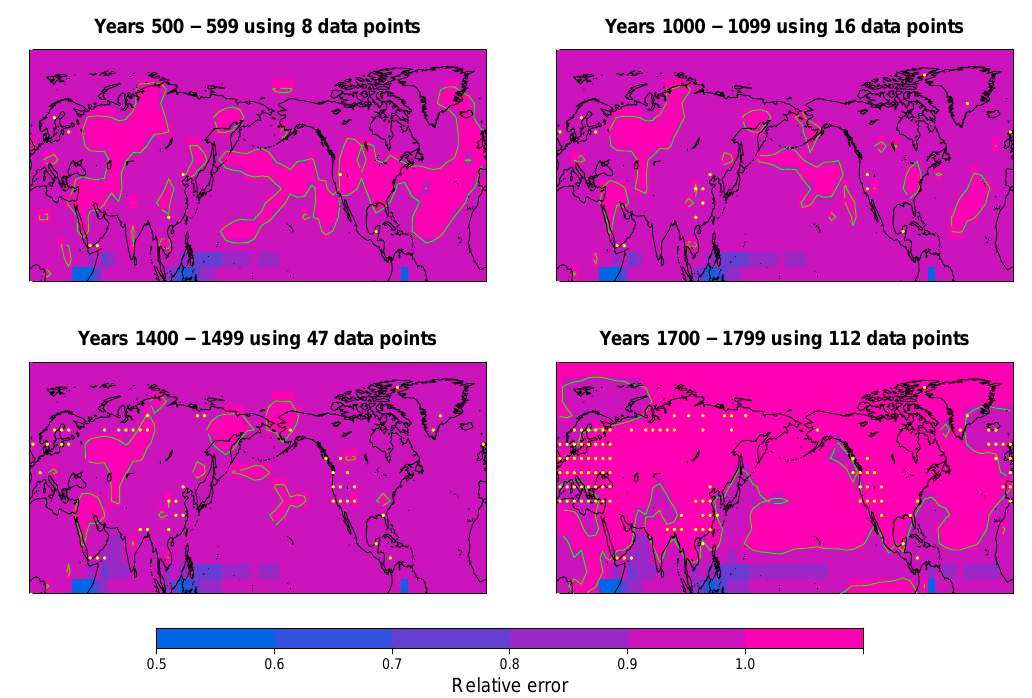
Fig. 6. Maps of normalised RMS reconstruction error for NH annual mean temperature anomalies for the case of externally forced changes, based on different number of proxy data points. Errors are normalised to standard deviation of climatology, with green contour indicating a normalised error of 1 (i.e. that the reconstruction is neither more nor less accurate on average than the prior climatological